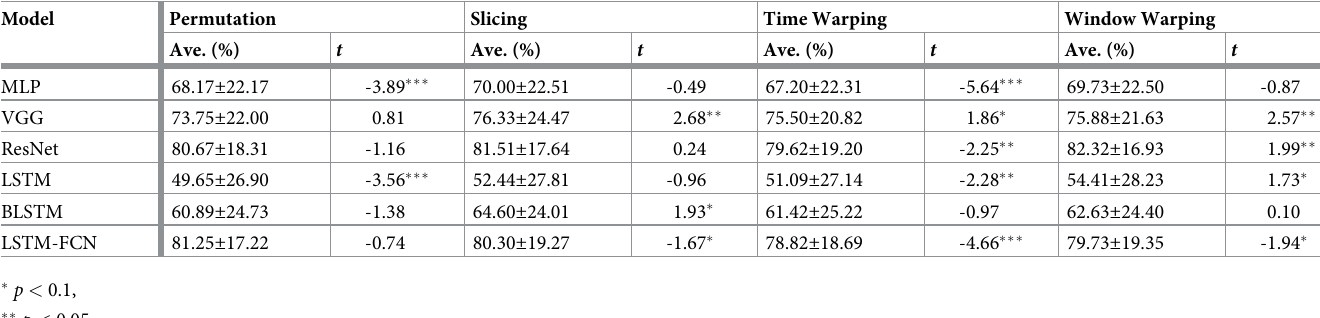
Table 2. Comparative results for time domain transformation-based data augmentation methods.